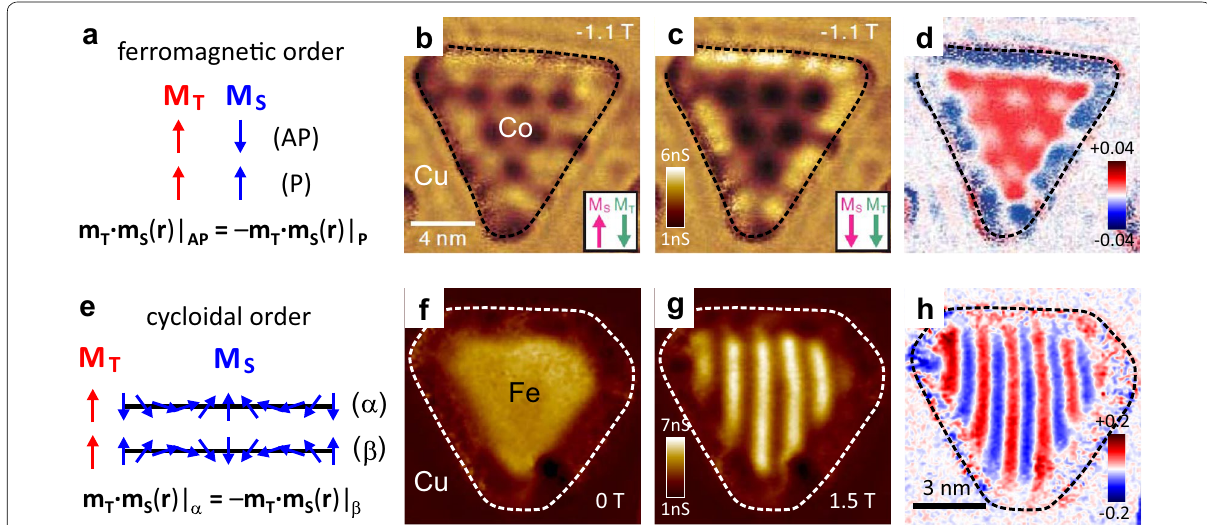
Fig. 11 Differential conductance asymmetry A dI/dV . a Two magnetic configurations in spin‑STM measurements, AP and P , corresponding to two distinct magnetic states of a bilayer Co nanoisland, pointing up and down, respectively. b , c d I /d V images of the Co nanoisland ‘A’ in Fig. 5 a measured at μ 0 H ext 1 T and V b 0.03 V for AP ( b ) and P ( c ) states. d A dI/dV map calculated from the d I /d V images of b and c . e Two relative = − = + magnetization configurations of spin‑STM measurements, corresponding to two distinct magnetic states of a bilayer Fe nanoisland, α and β. f , g d I / d V images of a Fe nanoisland, measured at external fields of ( b ) 0 T and ( c ) a value H sat . h A dI/dV map calculated from the d I /d V images of f and g . ≥ b – d Reprinted from [18] with permission from Institute of Physics (Copyright 2014). f – h Reprinted from [20] with permission from Nature Publishing Group (Copyright